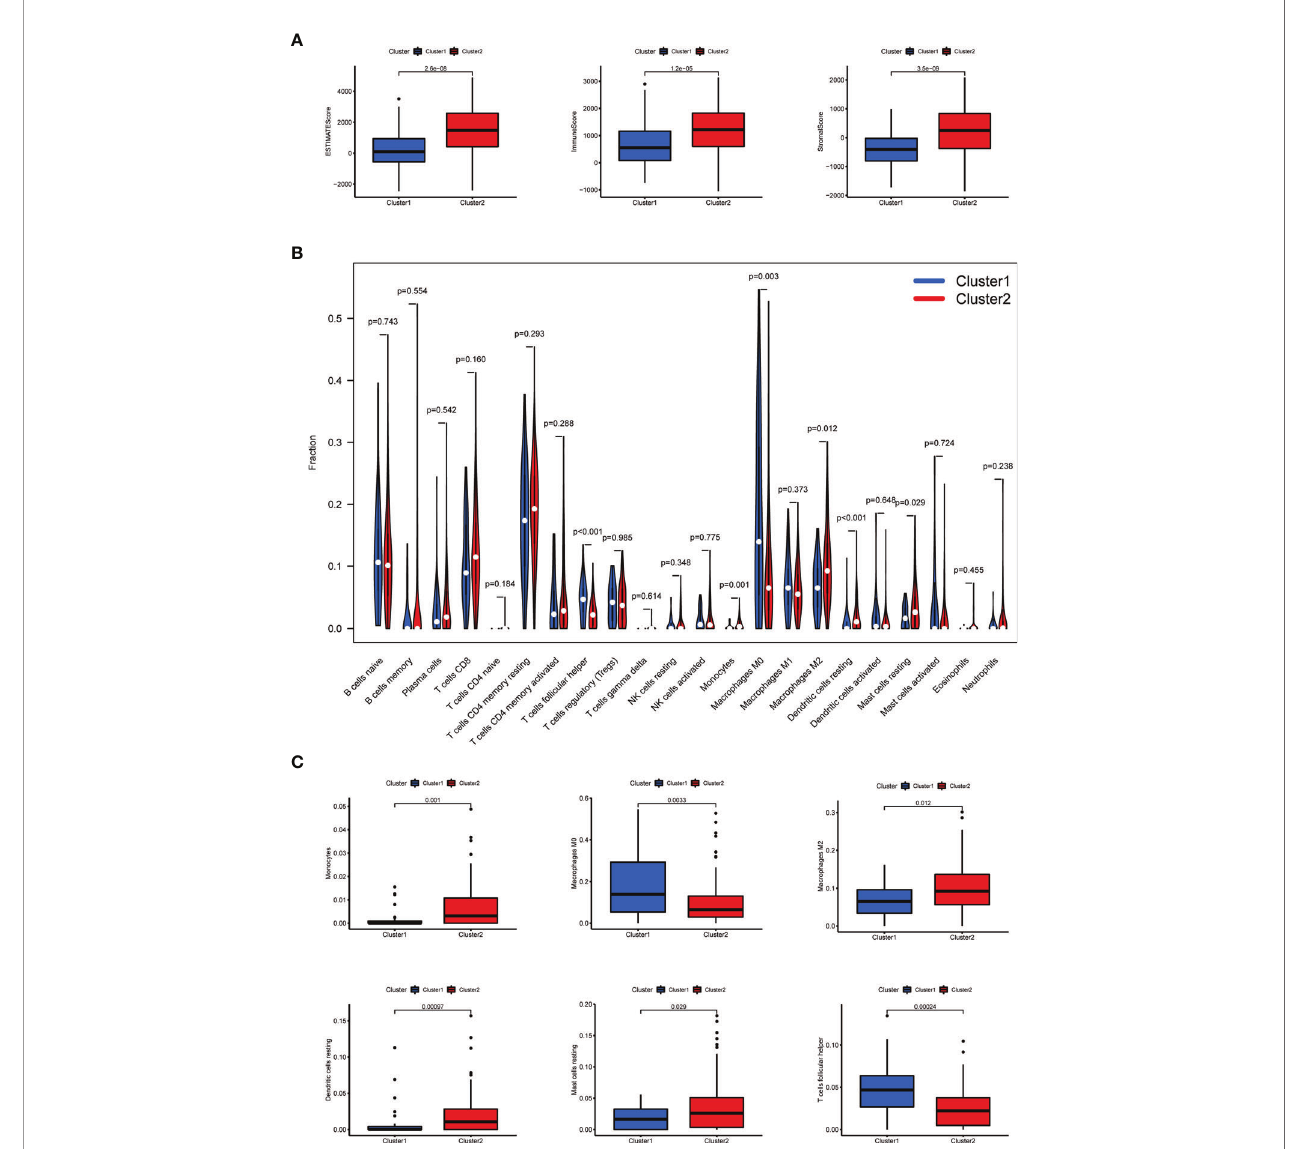
FIGURE 4 | The TME scores and the content of 22 immune cells in clusters I and II. (A) The ESTIMATE, immune, and stromal scores signi fi cantly increased in cluster II. (B) The content of 22 immune cells between clusters I and II. (C) The in fi ltration status of follicular helper T cells, M0 macrophages, M2 macrophages, monocytes, resting dendritic cells, and resting mast cells between cluster I and cluster II was signi fi cantly